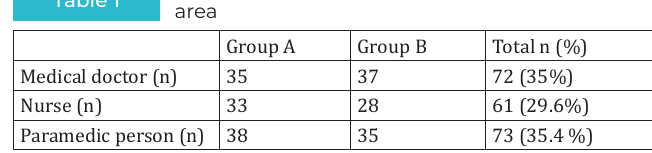
Profession of participant according to working